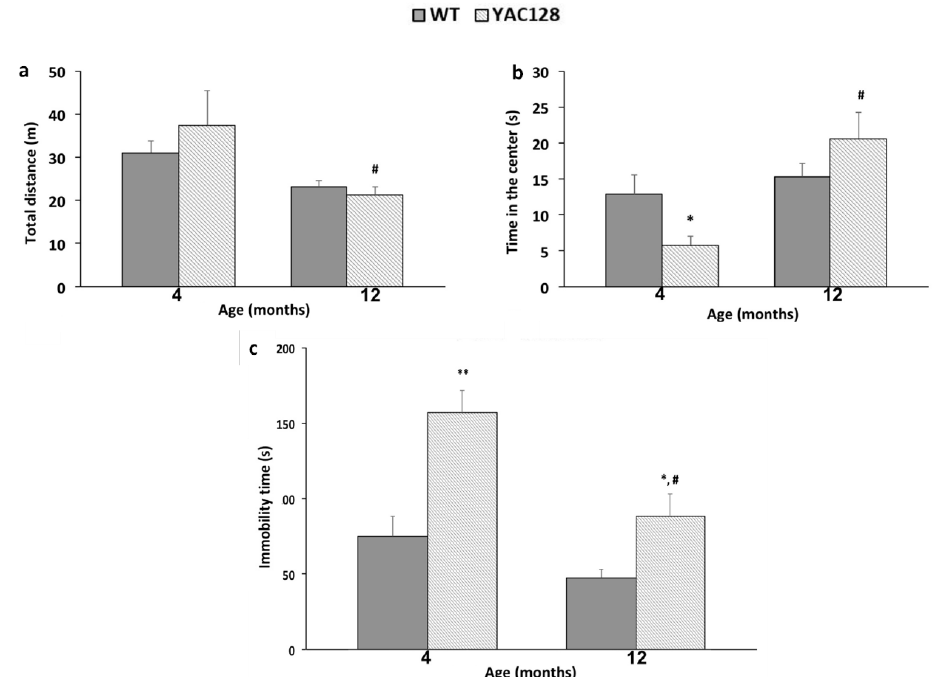
Figure 2. Effects of the genotype and stage of disease progression on the locomotor activity and motor coordination in WT and YAC128 mice, as assessed with the Open-Field Test (OFT). Distance traveled ( a ) and time spent in the center ( b ) were the parameters evaluated in the OFT. ( c ) Evaluation of depressive-like behavior in WT and YAC128 mice assessed by the Tail Suspension Test (TST) at 4 and 12 months of age. The total immobility time is represented as the mean ± SEM. The results were analyzed with two-way ANOVA, followed by Duncan’s multiple range post hoc test. n = 7–10 mice/group. * p < 0.05 and ** p < 0.01 when compared to the WT group; # p < 0.05 when compared to the 4-month-old YAC128 animals.